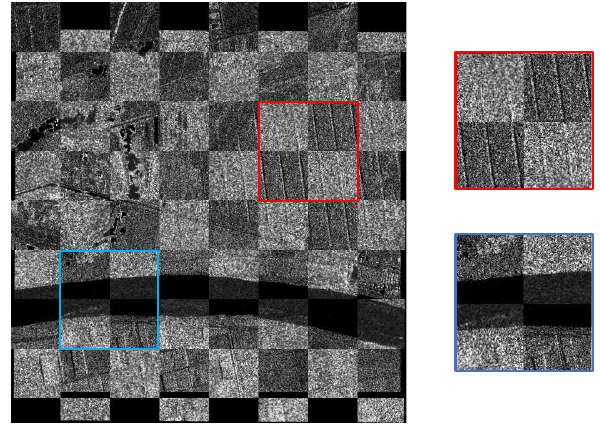
Figure 10. The Chessboard Mosaicked Image for YellowR1 Image.